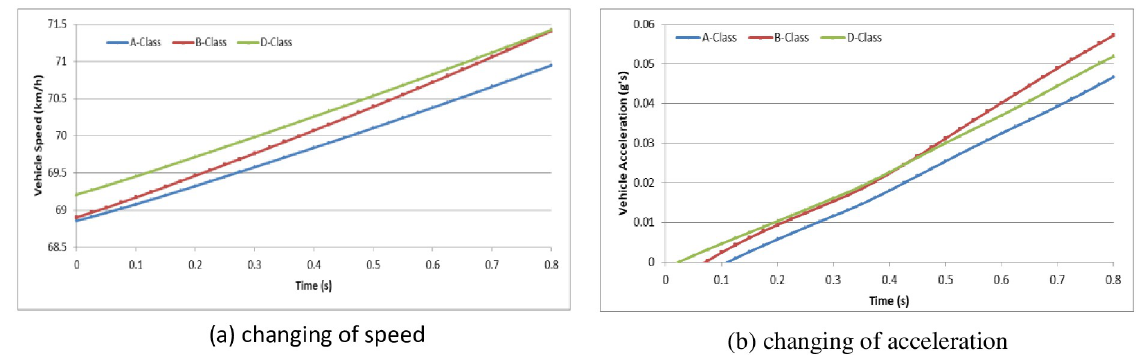
Fig 15. The changes in vehicle speed and acceleration during the reactions at initial speed = 70 km/h with different vehicle models (Group 2).